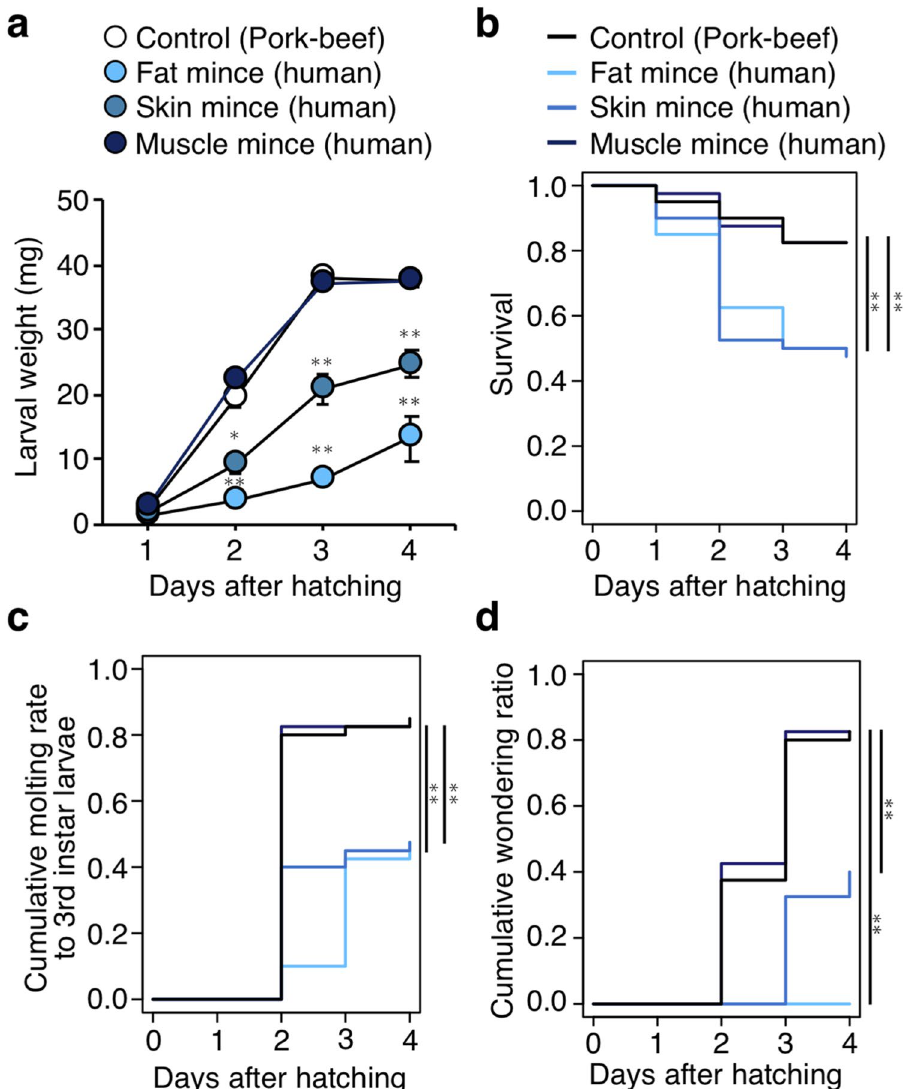
Figure 2. Human tissue-dependent growth and survivability of L. sericata larvae. ( a , b ) Weight and survival ratio of larvae fed on 16 g of pork-beef mince, human fat mince, human skin mince, or human muscle mince. n = 40 per group. The mean values are shown ± SEM in ( a ). Student’s t -test ( a ), two-sided log-rank test ( b ), * p < 0.05, ** p < 0.01. ( c , d ) Developmental rates of larvae (third instar and wandering) fed on 16 g of pork-beef mince, human fat mince, human skin mince, or human muscle mince. n = 40 per group. Two-sided log-rank test, ** p < 0.01. See also Supplementary Data 1 for data of experiment, exact sample sizes, and p